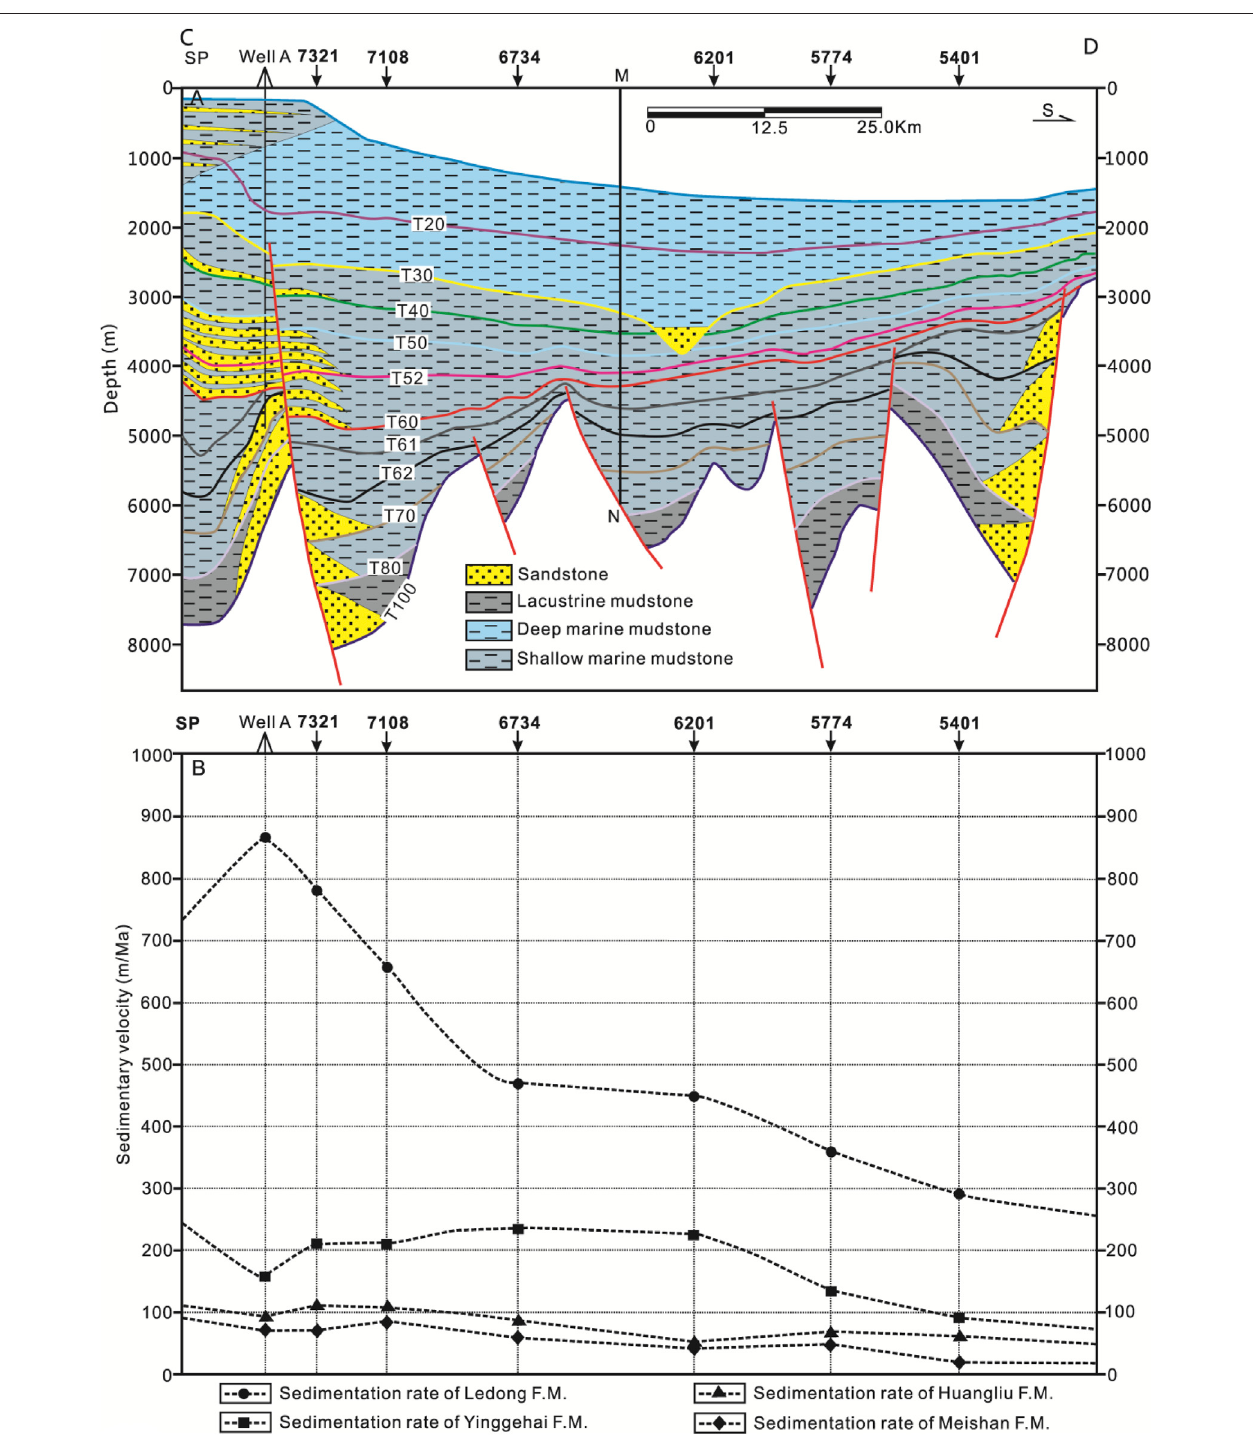
FIGURE 9 | (A) Lithologic cross-section of Pro fi le CD. (B) Sedimentation rates of the different formations showing the sedimentation rates of the Ledong and Yinggehai Formations were greater than other Formations. The cross section location is shown in Figure 1 .